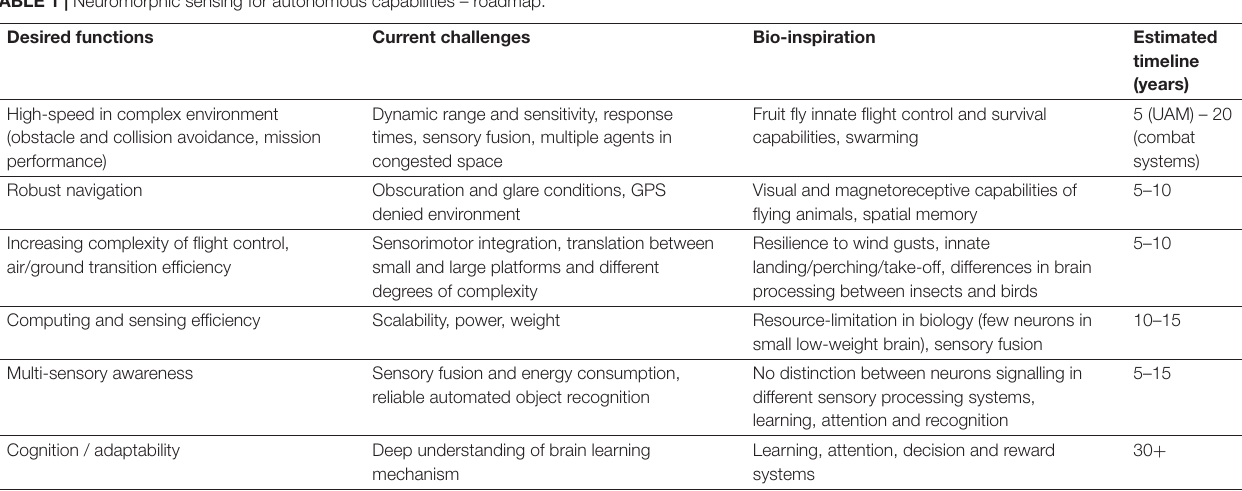
FIGURE 1 | Schematic route from bio-inspired behaviors toward neuromorphic sensors for autonomous flight. Animal figures are all covered by copyright with Creative Commons through https://www.pexels.com. TABLE 1 | Neuromorphic sensing for autonomous capabilities –